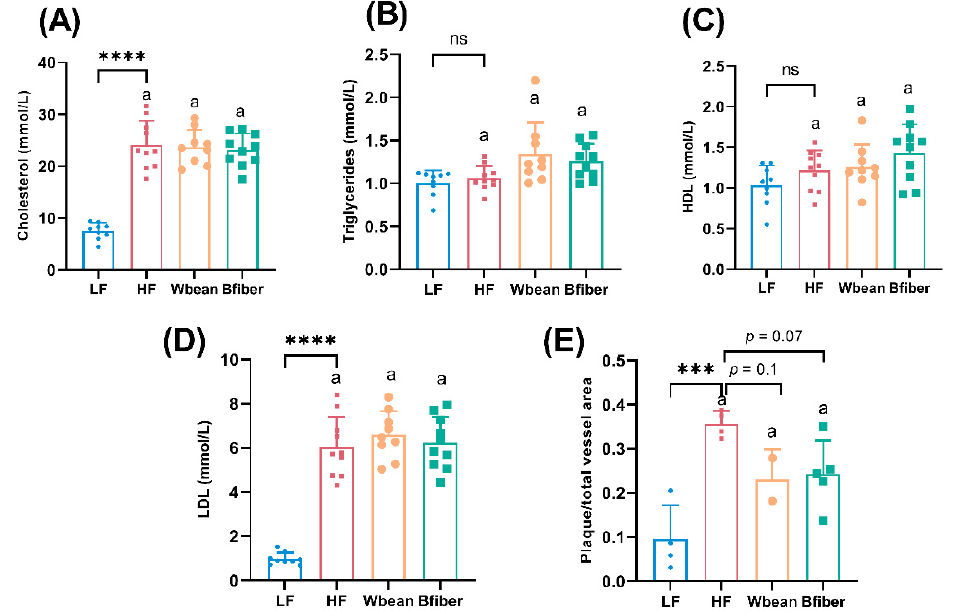
Figure 1. Plasma levels of ( A ) total cholesterol, ( B ) total triglycerides, ( C ) high density lipoprotein (HDL) cholesterol, ( D ) low density lipoprotein (LDL) cholesterol, and ( E ) atherosclerotic plaque amount in the aortic root of mice fed different diets for 10.5 weeks. Values in low fat (LF) and high fat (HF) groups were compared using Student’s t -test (or Welch’s t -test for data with unequal SDs). Values in the high fat groups, i.e., HF, whole brown bean (Wbean), and bean fiber (Bfiber), were compared using one-way ANOVA (Welch’s ANOVA test for data with unequal SDs, or Kruskal– Wallis test for nonparametric data) followed by post hoc tests. Different lowercase letters within panels indicate significant differences ( p < 0.05). ns: not significant. *** p < 0.001, **** p <